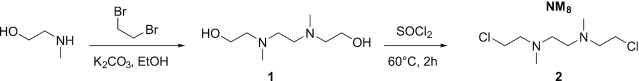
Synthesis of NM8.